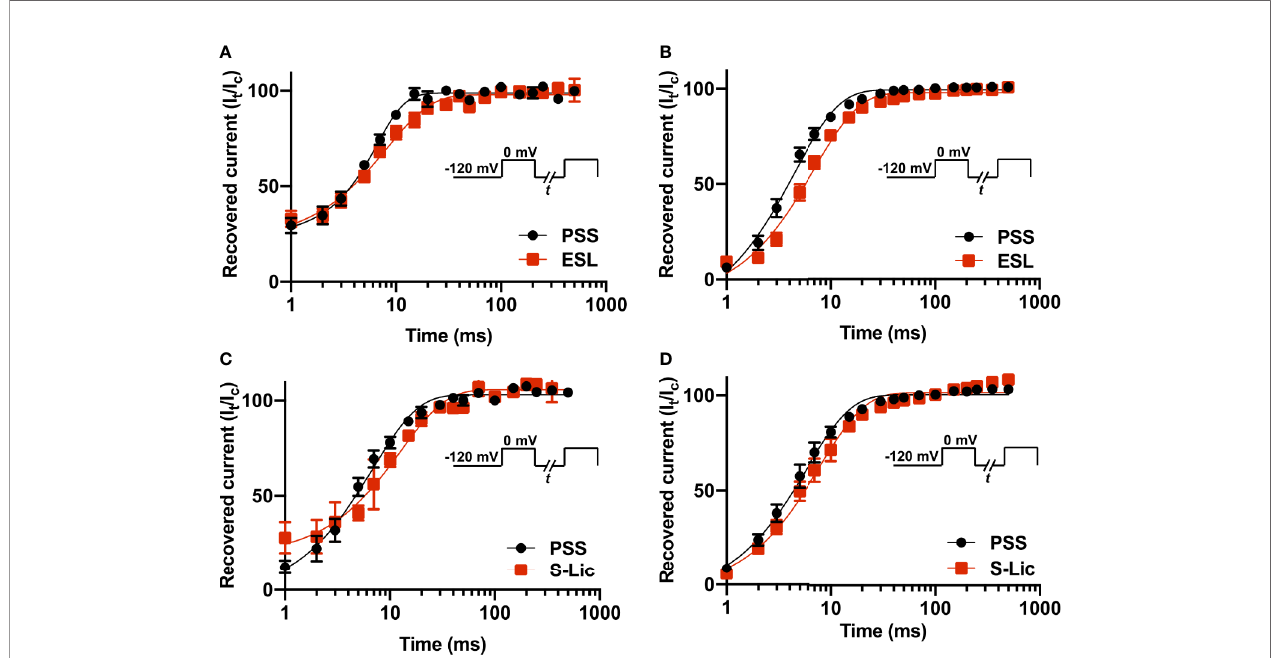
FIGURE 6 | Effect of eslicarbazepine acetate and S-licarbazepine on recovery from inactivation. (A) Recovery from inactivation in MDA-MB-231 cells in physiological saline solution (PSS; black circles) and in eslicarbazepine acetate (ESL; 300 m M; red squares). (B) Recovery from inactivation in HEK-Na v 1.5 cells in PSS (black circles) and ESL (300 m M; red squares). (C) Recovery from inactivation in MDA-MB-231 cells in PSS (black circles) and S-licarbazepine (S-Lic; 300 m M; red squares). (D) Recovery from inactivation in HEK-Na v 1.5 cells in PSS (black circles) and S-Lic (300 m M; red squares). The fraction recovered (I t /I c ) was determined by a 25 ms pulse to 0 mV (I c ), followed by a recovery pulse to -120 mV for 1 – 500 ms, and a subsequent 25 ms test pulse to 0 mV (I t ), applied from a holding potential of -120 mV, and plotted as a function of the recovery interval. Data are fi tted with single exponential functions which are statistically different between control and drug treatments in all cases. Results are mean ± SEM (n = 7 –